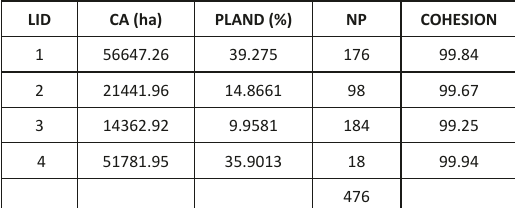
Table 4. Class metric